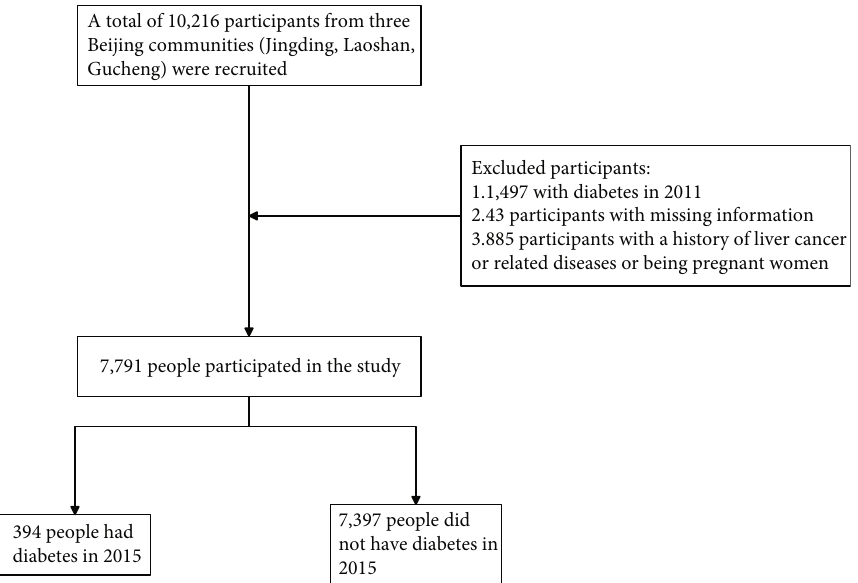
Figure 1: Flow chart of the study participant selection